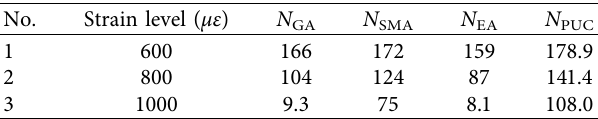
Table 8: Fatigue life comparison between polyurethane cement and asphalt concrete (10 4 ).